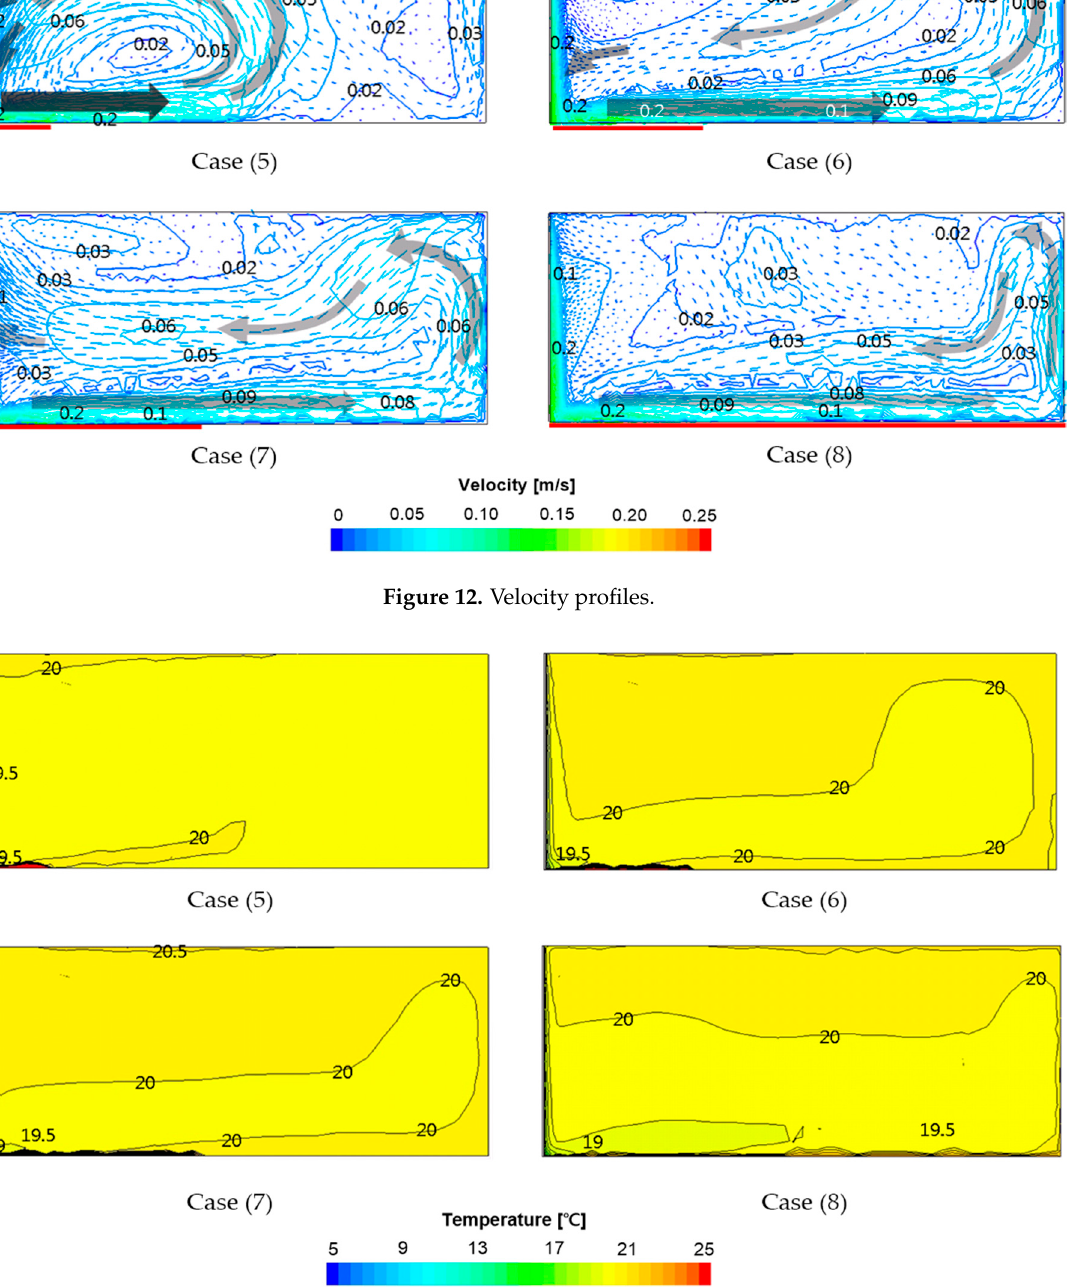
Figure 13. Distribution of temperature.